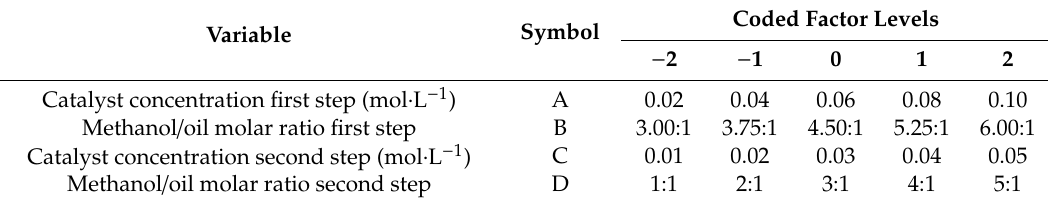
Table 10. Factors and their levels for response surface design.